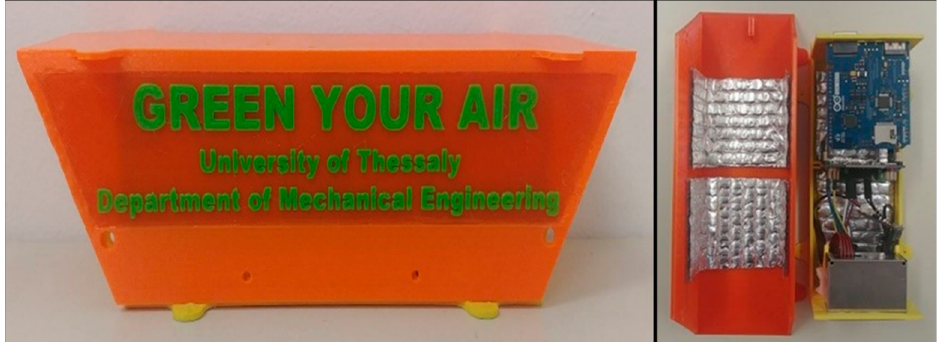
Figure 1. GreenYourAir device 1178/PM 2.5 .